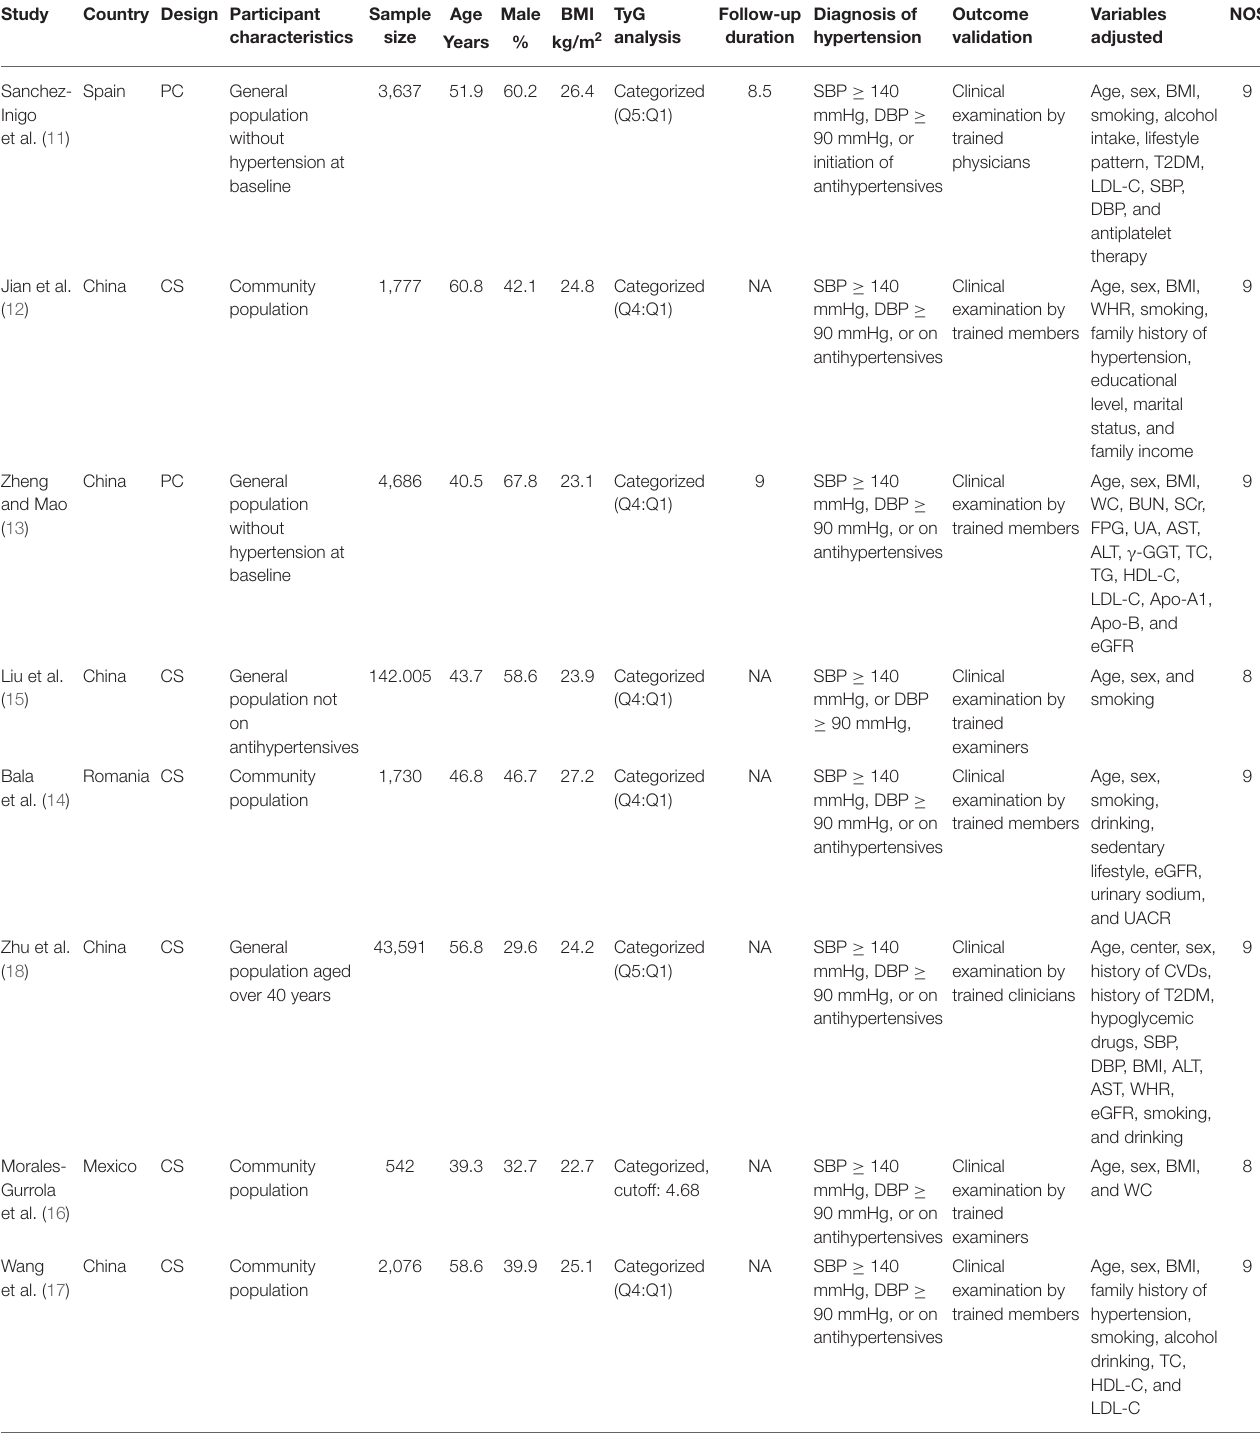
TABLE 1 | Characteristics of the included observational studies.